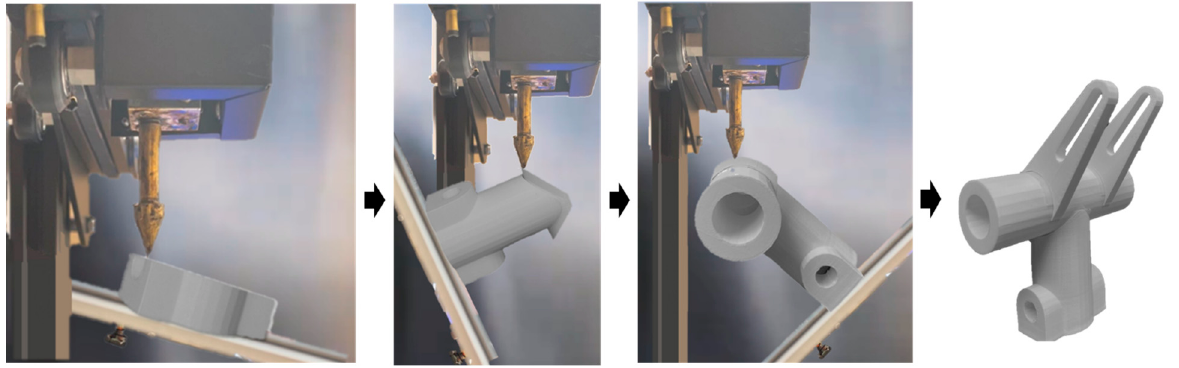
Figure 18. Printing Process for the model (b) in Figure